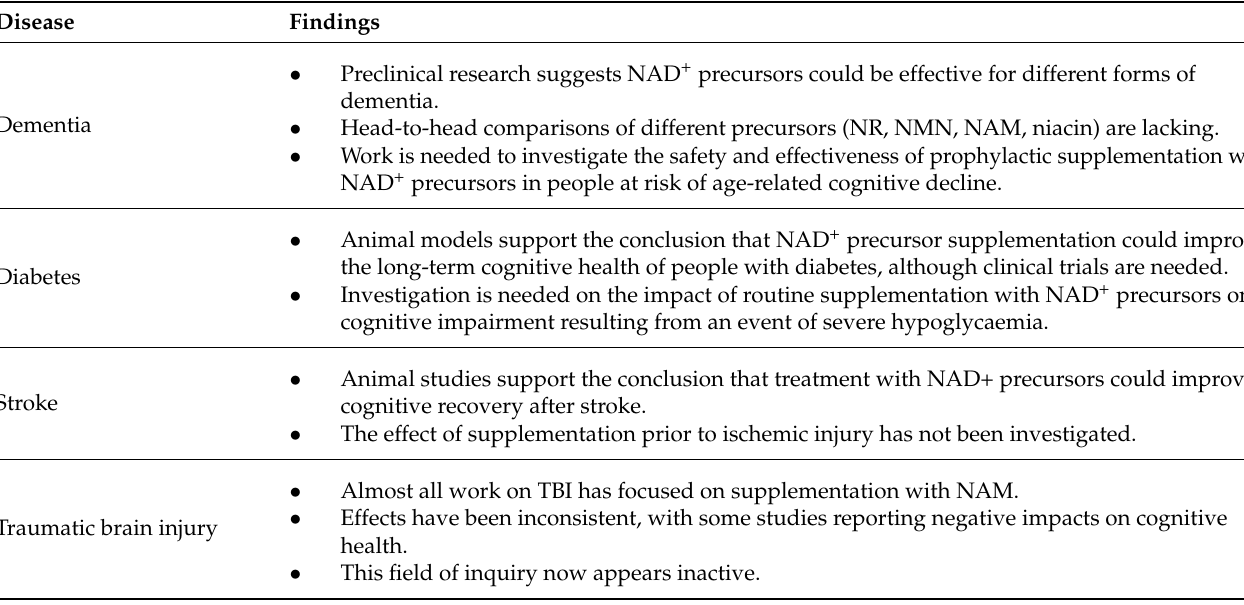
Table 1. Summary of major